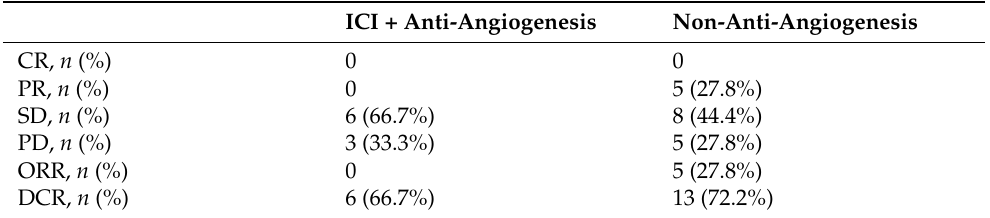
Table A2. Efficacy of PD-1 inhibitors combined with anti-angiogenesis therapy in NSCLC patients with liver metastasis in ≥ 2